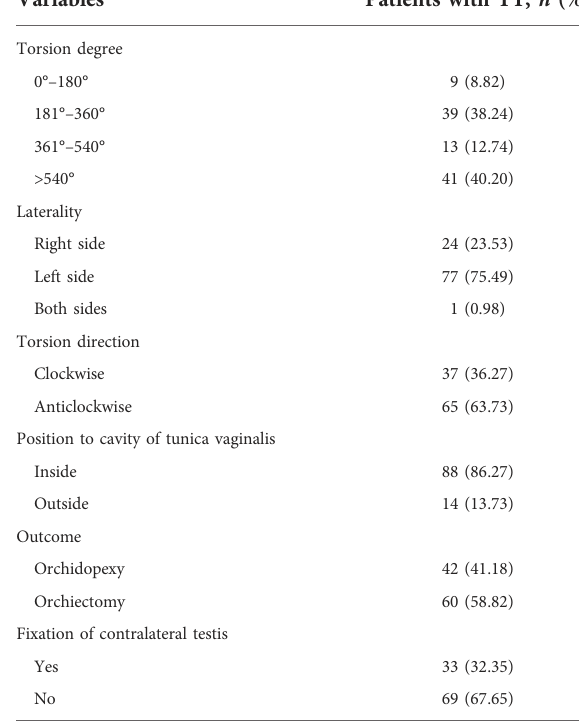
TABLE 2 Operative fi ndings and surgical outcomes in patients with